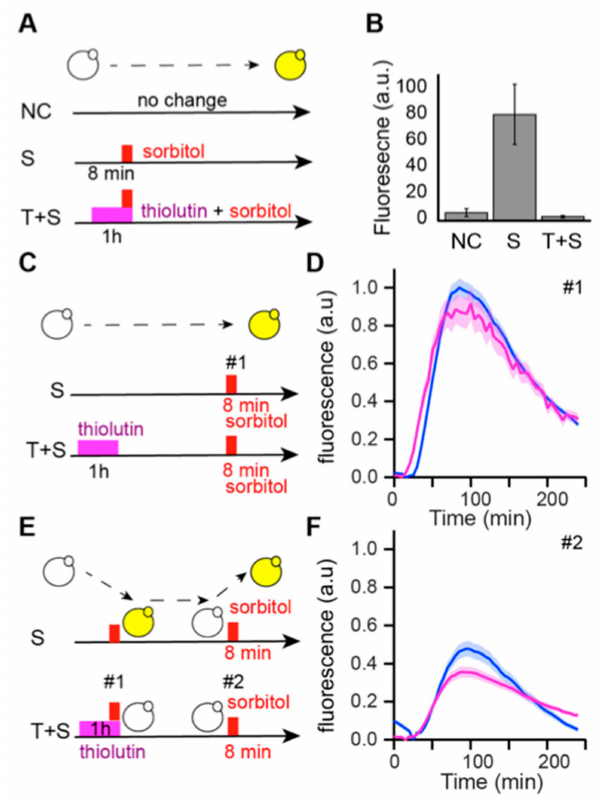
Figure 3. ( A ) Principle of the transcription inhibition experiment using thiolutin. Non-stressed cells received no sorbitol (NC) and stressed (S) cells were subjected to 8 min hyperosmotic stress (small red rectangle). (T + S) cells were treated with thiolutin for 1 h (pink rectangle) prior to and during stress. ( B ) Single-cell quantification of cellular fluorescence after 70 min under non-stress conditions (NC), hyperosmotic conditions (S) and hyperosmotic conditions in the presence of thiolutin (T + S). ( C ) Principle of the experiment to control thiolutin wash out. (Upper row). (S) cells were cultured in the microfluidic device for 4 h before being exposed to 8 min hyperosmotic stress. (Lower row) (T + S) cells were treated with the transcriptional inhibitor thiolutin for 1 h, thiolutin was washed out for 4 h and then cells were exposed to 8 min hyperosmotic stress. ( D ) pSTL1 fluorescence responses of cells treated ( n = 101, pink) or untreated ( n = 97, blue) with thiolutin after stress; similar responses were observed. Fluorescence levels were normalized to the peak fluorescence value of non-treated cells. ( E ) Principle of quantification of the memory e ff ect in the presence of thiolutin. (S) cells were exposed to two 8 min hyperosmotic stresses 4 h apart. (T + S) cells were treated with thiolutin for 1 h and exposed to 8 min hyperosmotic stress, thiolutin was washed out for 4 h and cells were then exposed to a second 8 min stress. ( F ) Population quantification of stress memory for cells subjected to a first stress in the absence (blue) or presence of thiolutin ( n = 101, pink). Fluorescence levels were normalized to the peak fluorescence value of the non-treated cells presented in ( D